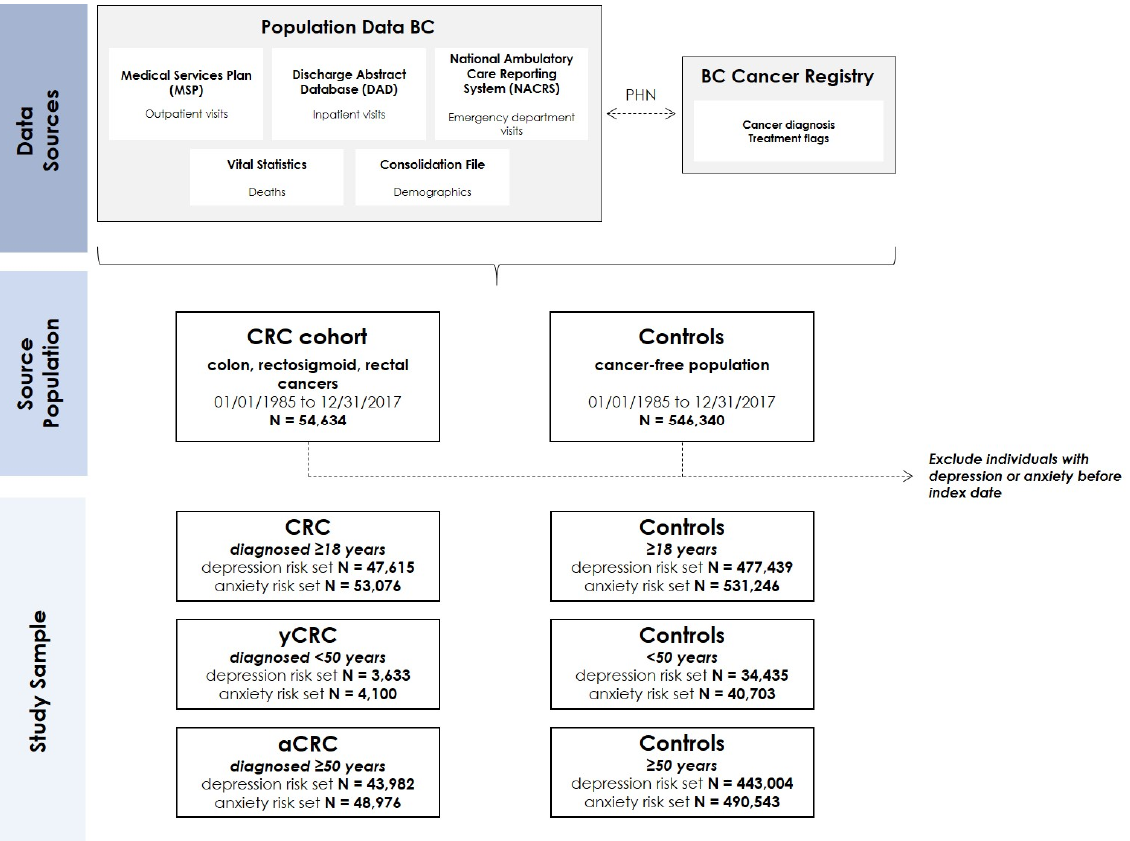
Figure 1. Overview of data source, source population and study sample (dashed arrows show linkages between databases using personal health numbers which are then de-identified/scrambled). The risk set refers to individuals without a history of depression or anxiety and are therefore considered at risk for incident depression or anxiety and included in the study sample for each respective analysis. Abbreviations: